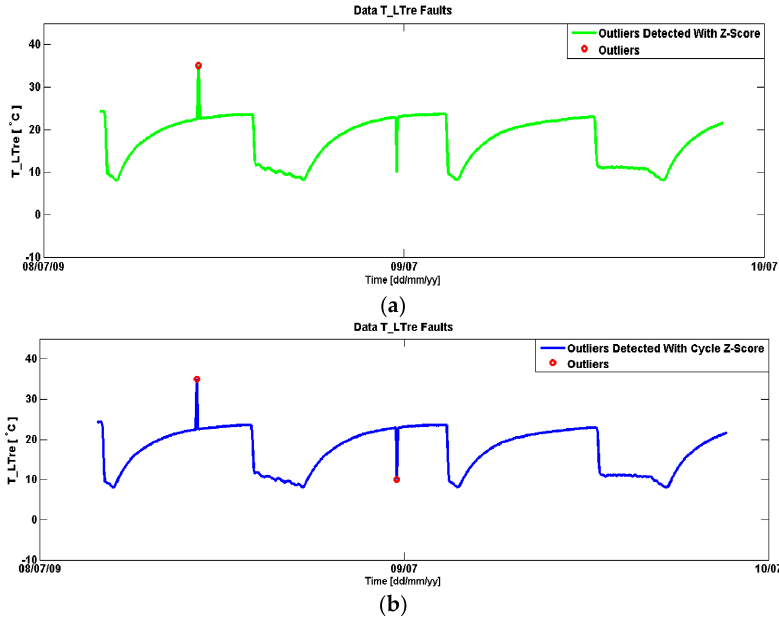
Figure 9. Outliers in data ( a ) Outliers detected with normal z ‐ score ( b ) Outliers detected with cycle based z ‐ score.